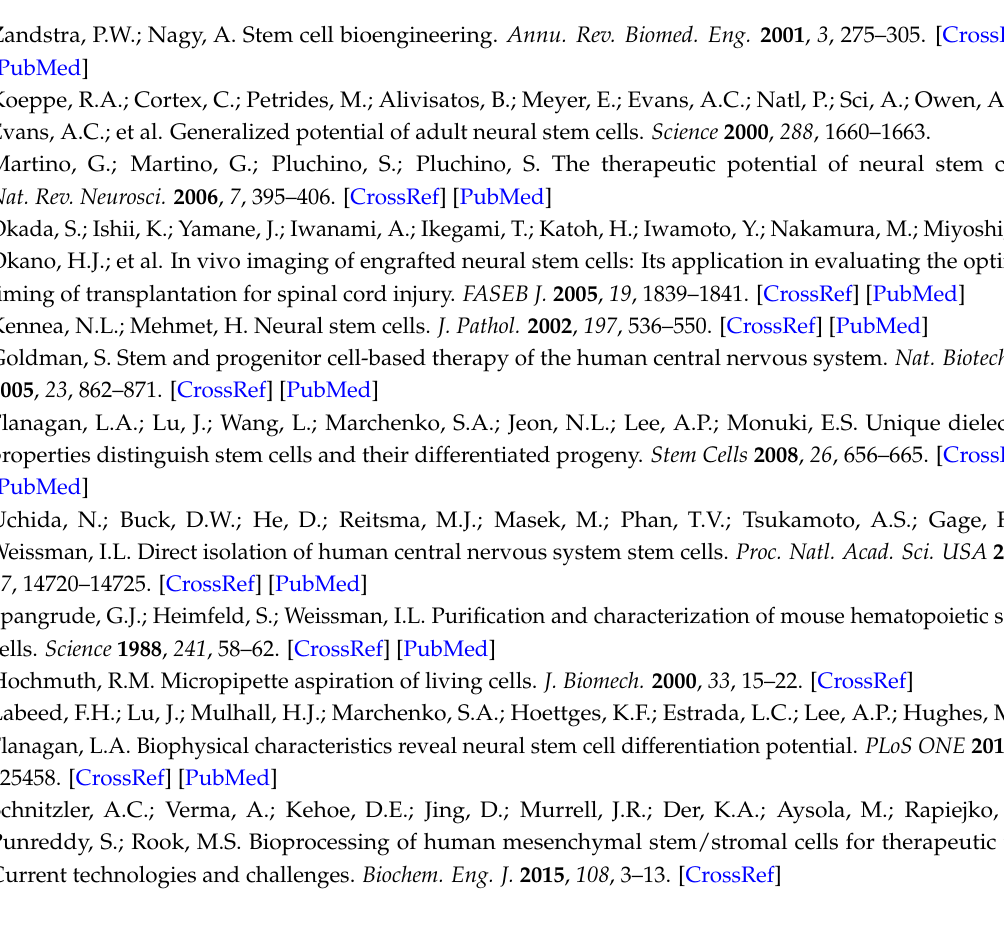
Table S1: Parameters defined for the simulation. Table S2: Equations defined for the simulation. Acknowledgments: The authors acknowledge Rohan Galgalikar for his help during data processing using MATLAB